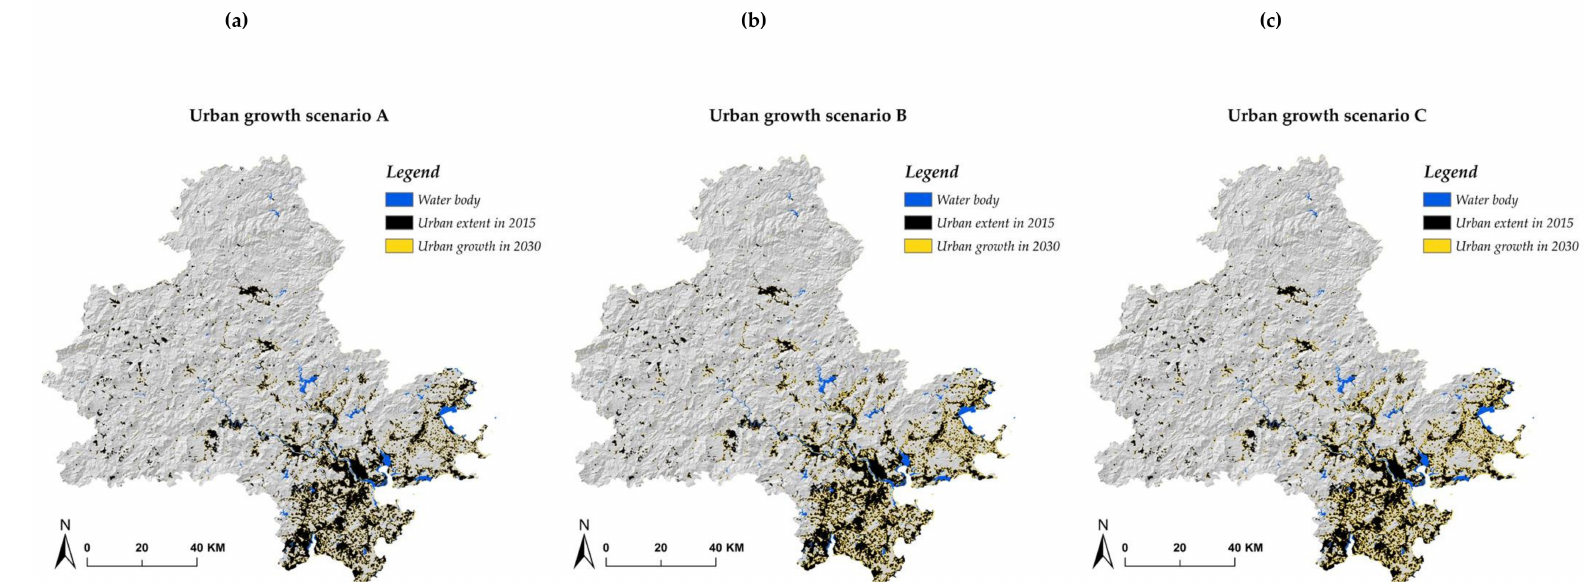
Figure 6. ( a ) Urban growth scenario A; ( b ) Urban growth scenario B; ( c ) Urban growth scenario